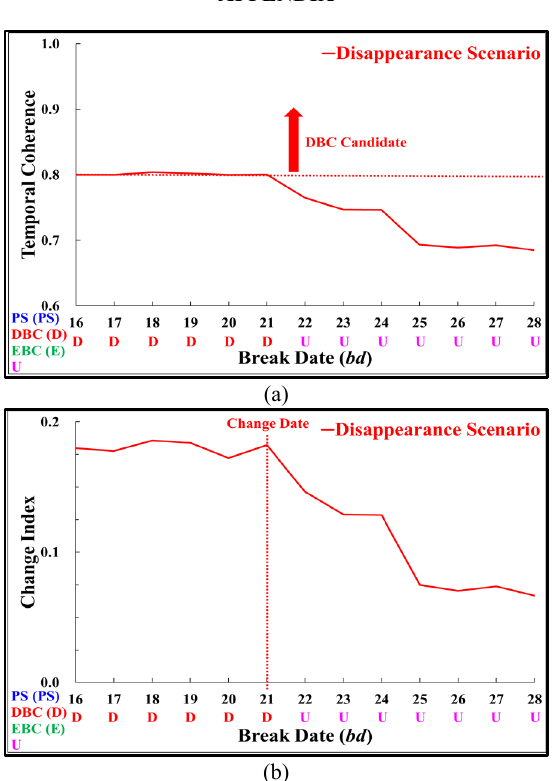
Figure A.1. Example of DBC point’s (a) temporal coherence sequence and (b) chance index sequence along with initial point labels.